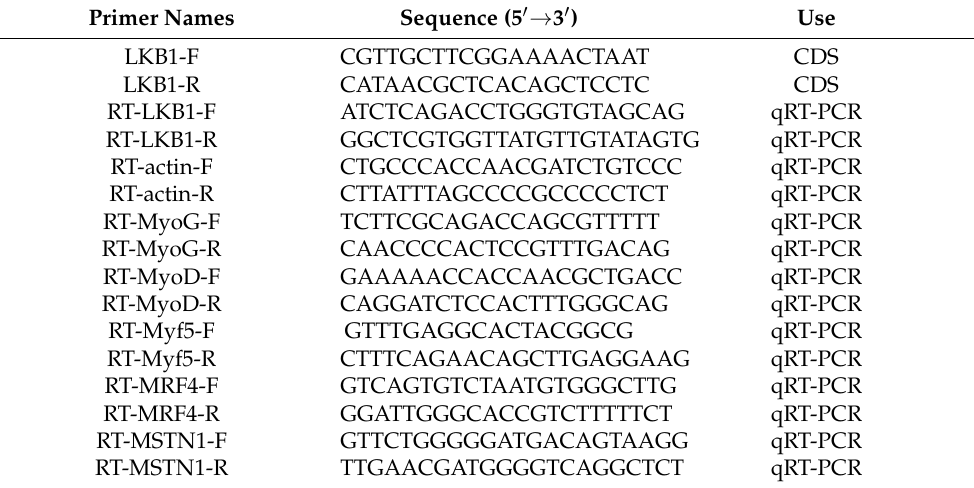
Table 1. The sequences of primers used in this